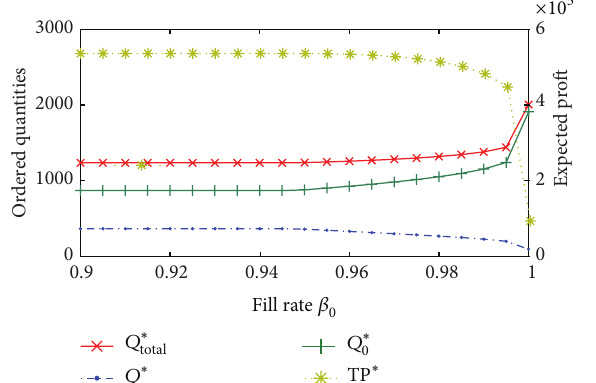
Figure 4: Effect of 𝛽 0 on the optimal policy.